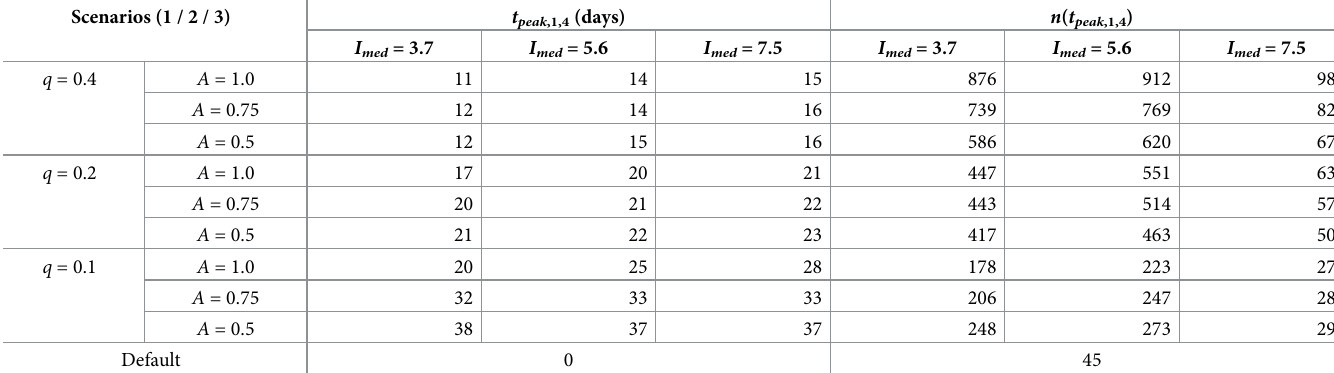
Table 7. Demonstration of the effects of the speed of testing. Scenarios (1 / 2 /